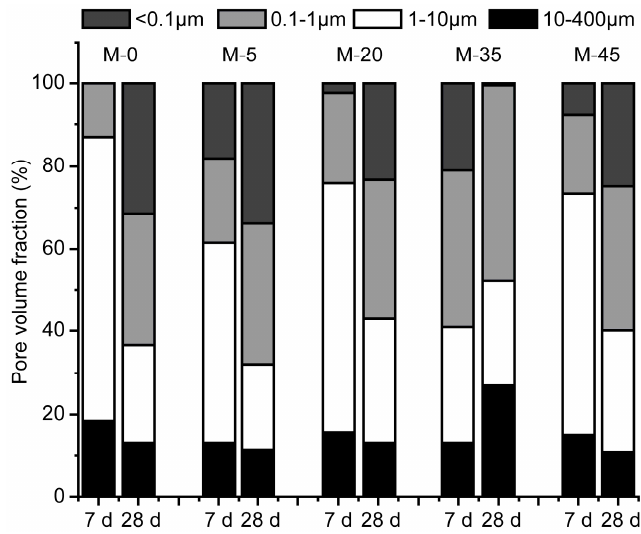
Figure 5. Evolution of the pore volume fractions observed for the aged CPB specimens.